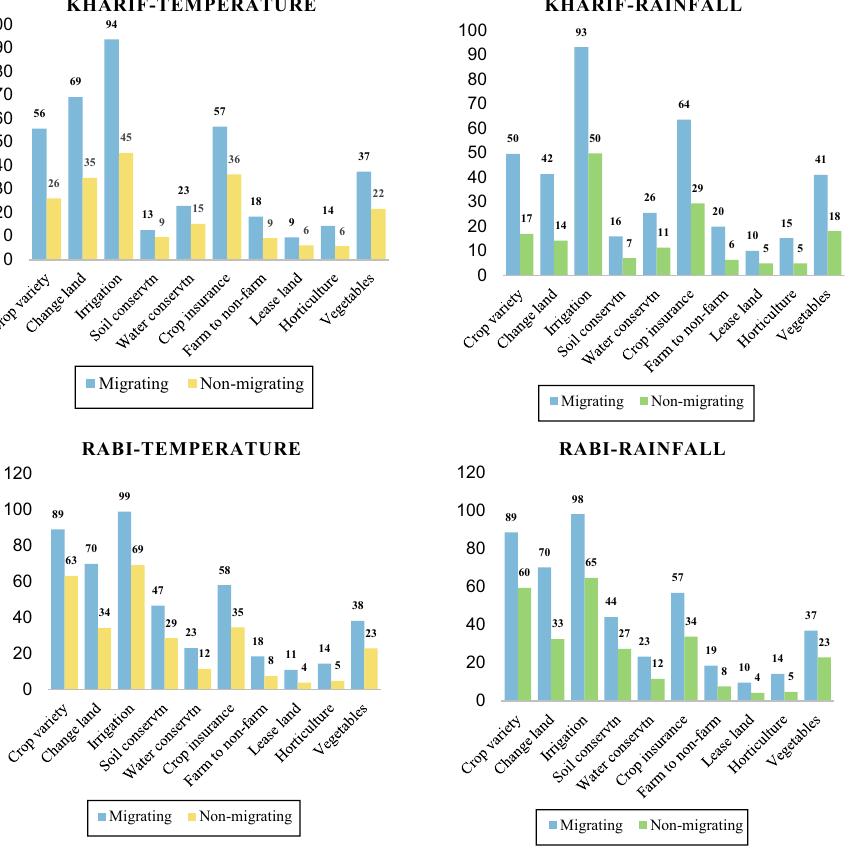
Figure 3. Adaptation strategies of migrant and non- migrant